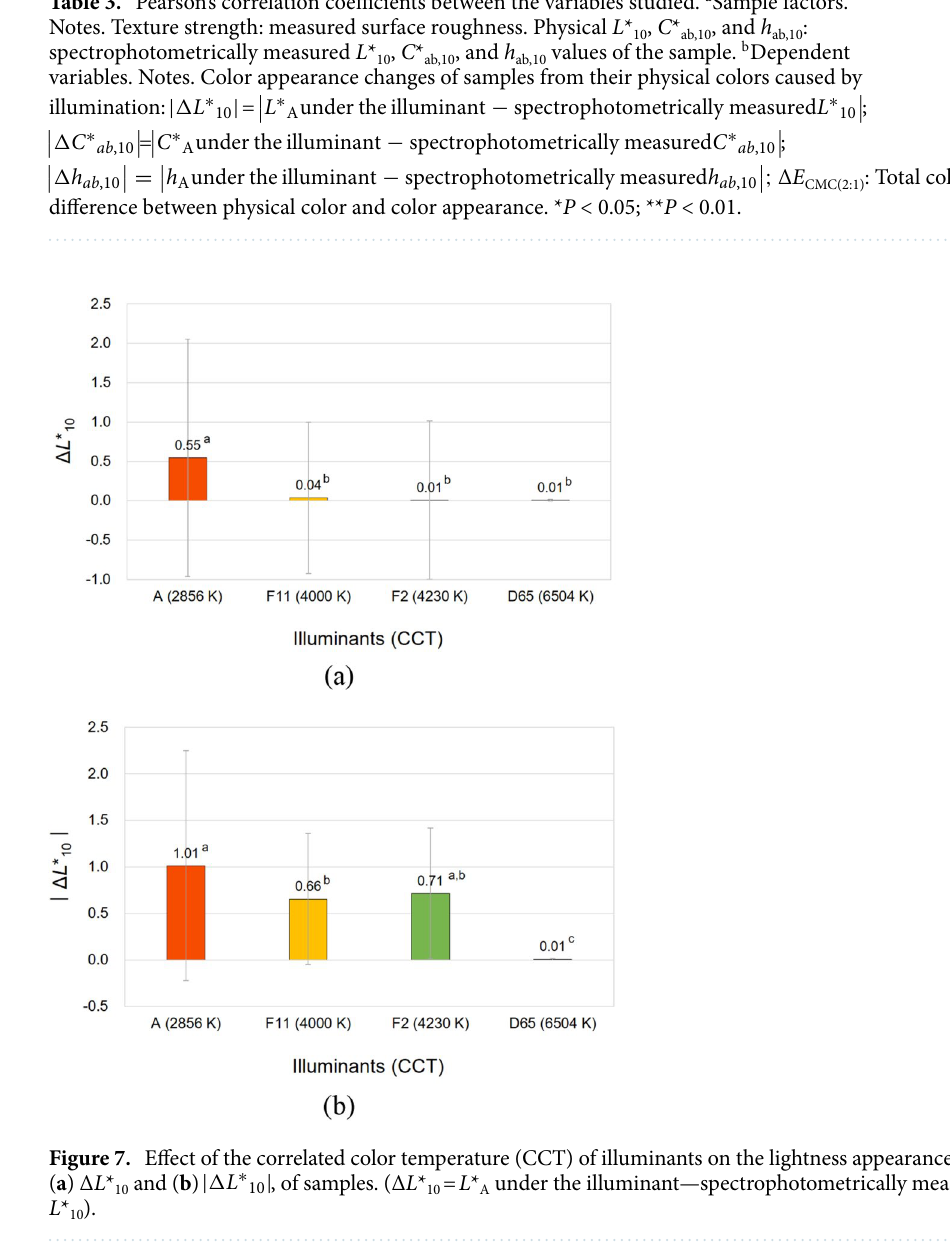
Table 3. Pearson’s correlation coefficients between the variables studied. a Sample factors.